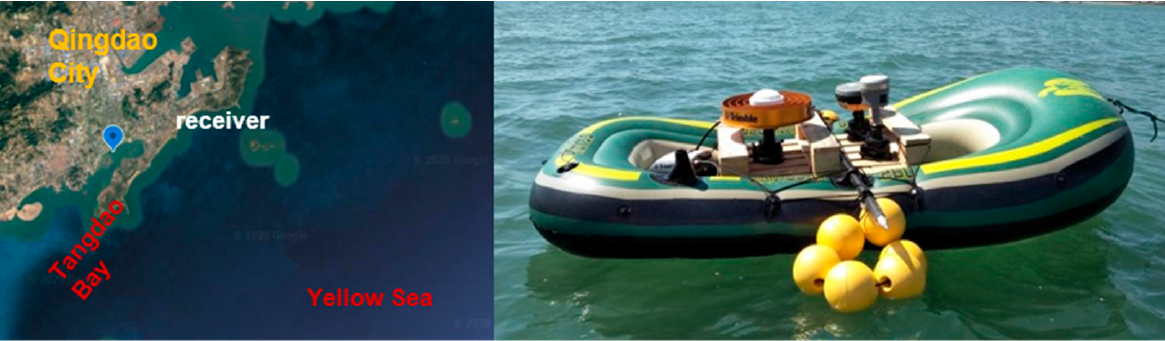
Figure 10. Experimental site ( left ) and setup ( right ).